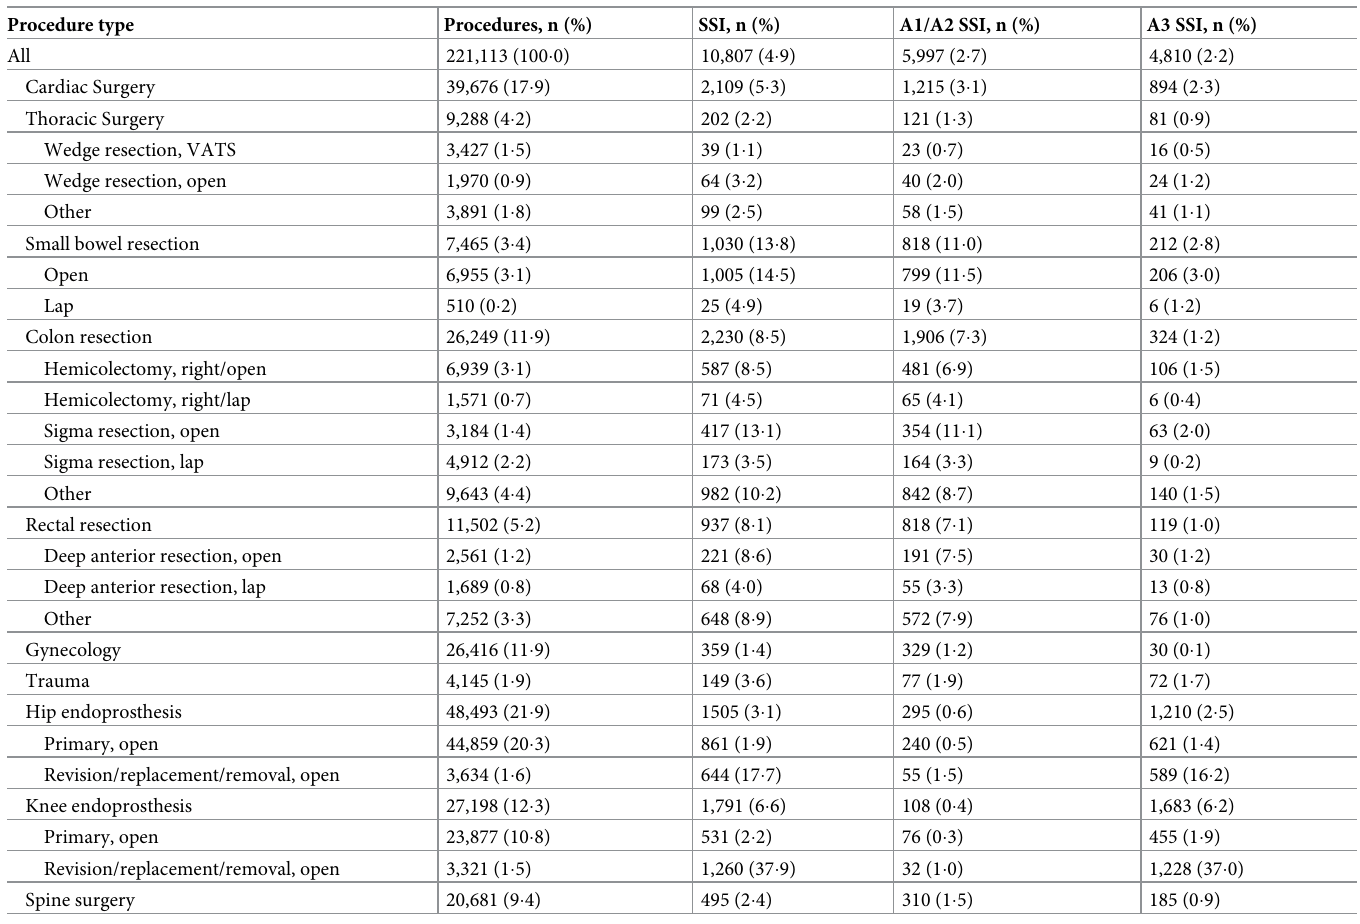
Table 2. Frequency of SSI by procedure type and NRZ classification,